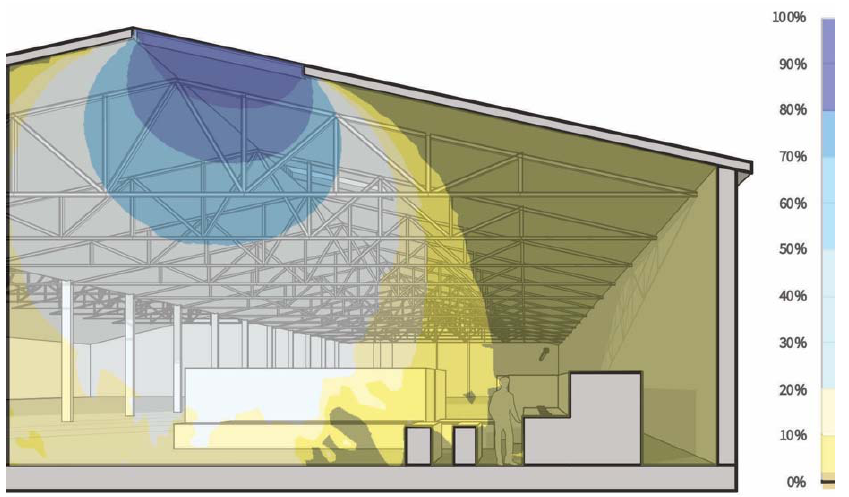
Figure 2. Simulation results for a vertical cut through the quality control workplace and the skylight. The false-color scale shows the daylight autonomy in percent for a 240 lx threshold during a time window of 8–11